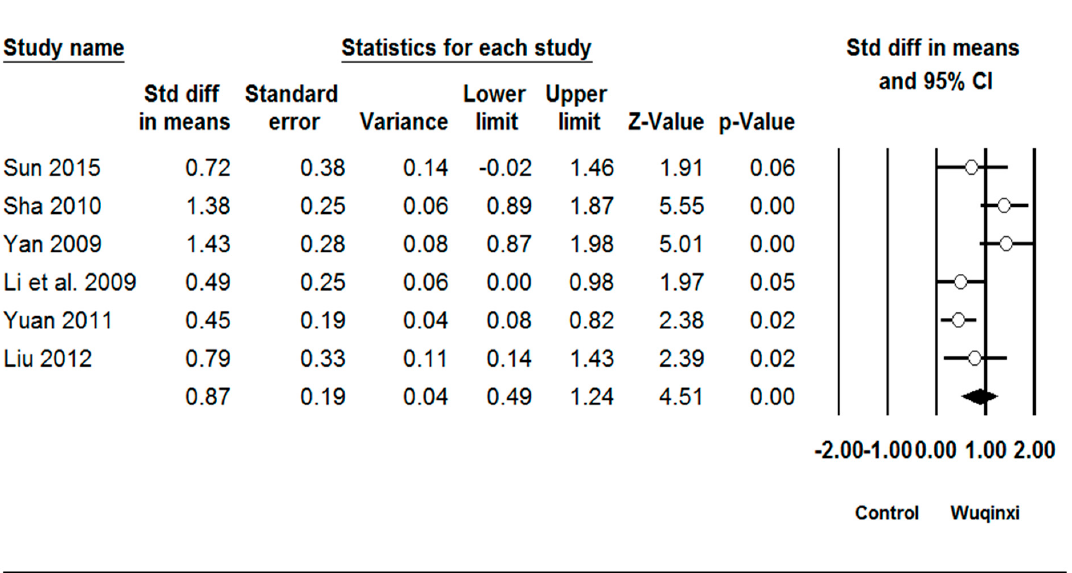
Figure 5. Effect of Wuqinxi on triglycerides. Effect size (95% CI) of each study is denoted by circle (black line). The mid-point of the circle represents the point effect estimate, meaning effect estimate for each study. The area of the circle represents the weight given to the study. The diamond below the studies represents the overall effect.